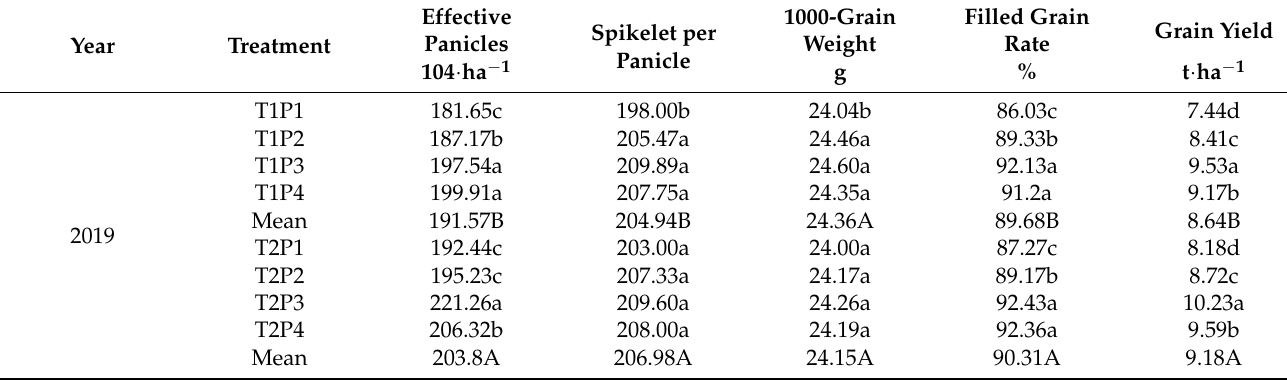
Table 4. Rice yield and yield components under different treatments in 2019 and